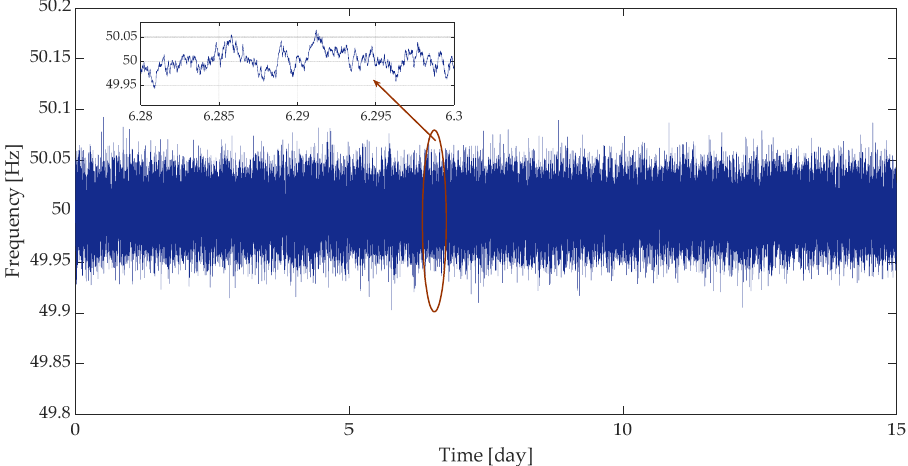
Figure 12. Frequency data estimated according to the Ornstein–Uhlenbeck process.